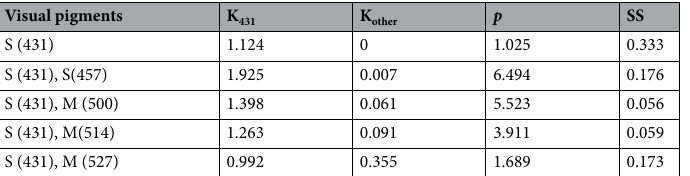
Table 1. Best-fit Simplex derived parameters and corresponding least sum of squares (SS) for the spectral functions depicted in Fig. 8H. The k 431 and k other coupling constants are the inputs of the visual pigments to the absorbance function [k 431 corresponds to the S(431) visual pigment and k other to the other pigment in a combination]. The λ max of the visual pigments used in the fitting process are indicated in the first column. The SS statistic is derived from the sum of differences between mean absorbance data and the corresponding values predicted by the Simplex